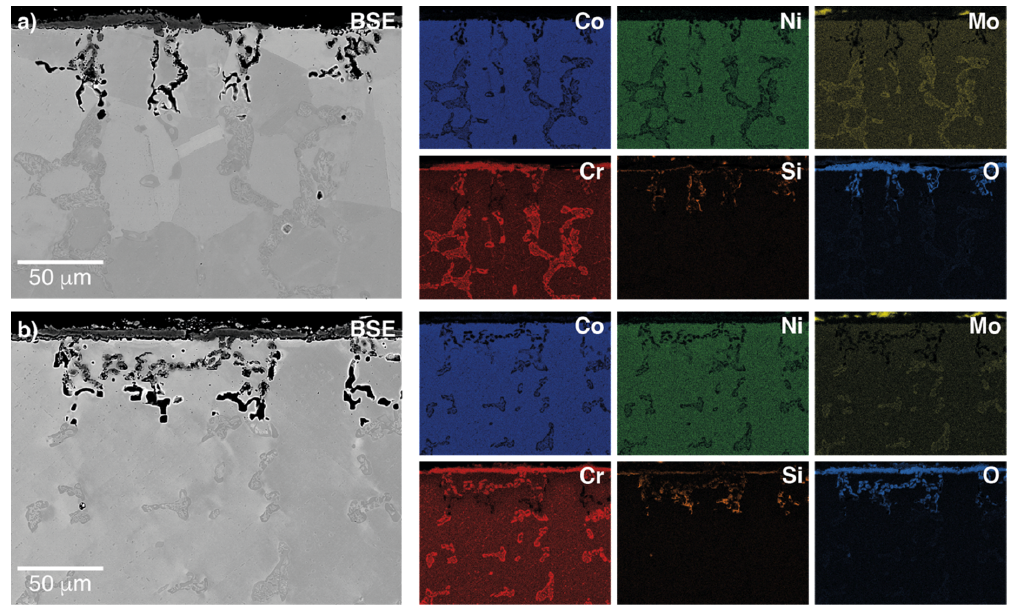
Figure 6. BSE images and corresponding Co, Ni, Mo, Cr, Si, and O EDX element distribution maps after 100 h oxidation at 1000 °C for ( a ) as-cast and ( b ) 1250 °C 10 h heat treated Co-101.